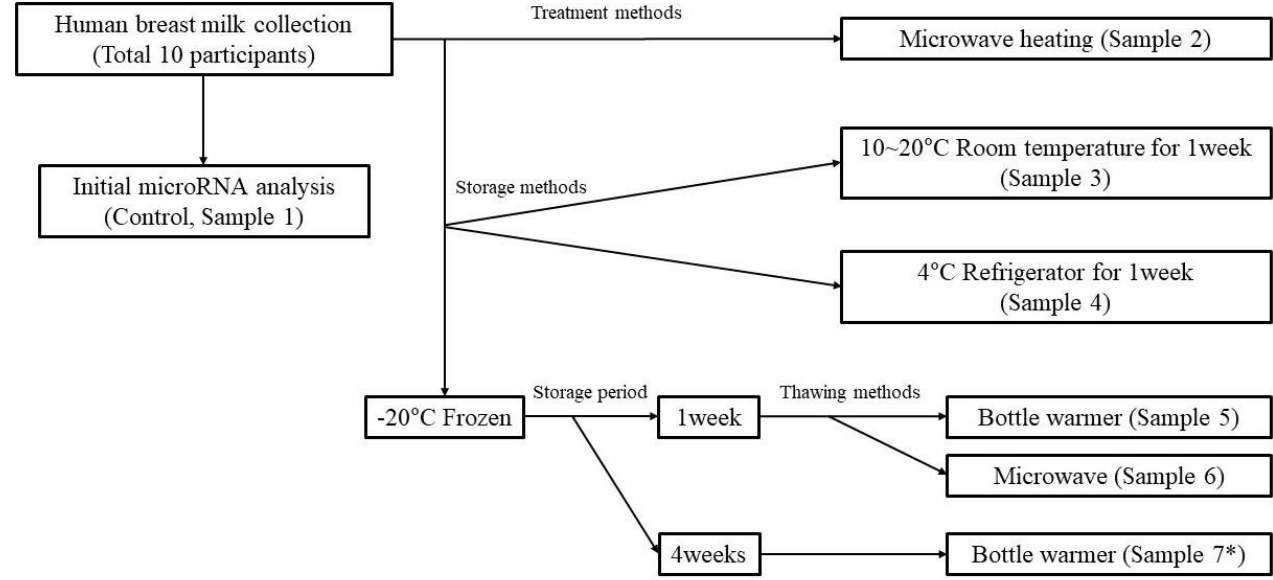
Figure 1. Process of treatment, storage, and thawing of collected breast milk. * Sample 7 treatment procedure was conducted in all participants except for Participant 5.